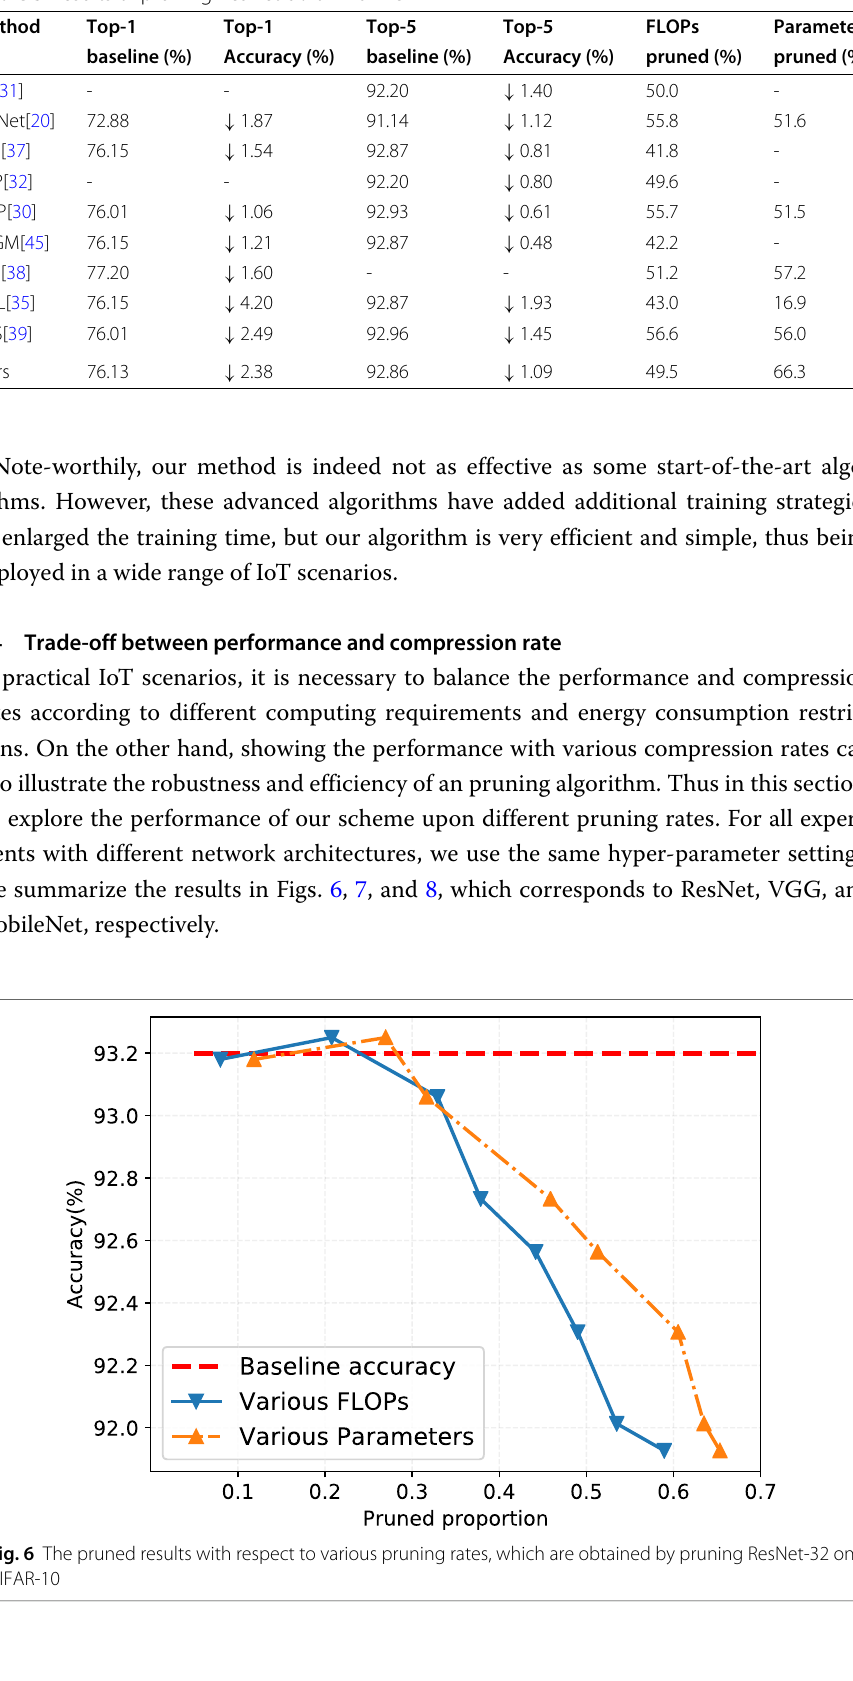
Table 5 Results of pruning ResNet-50 on